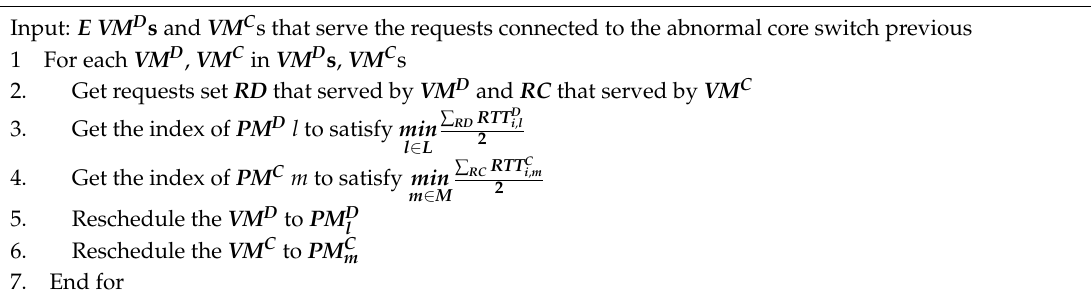
Algorithm 4 VM rescheduling algorithm